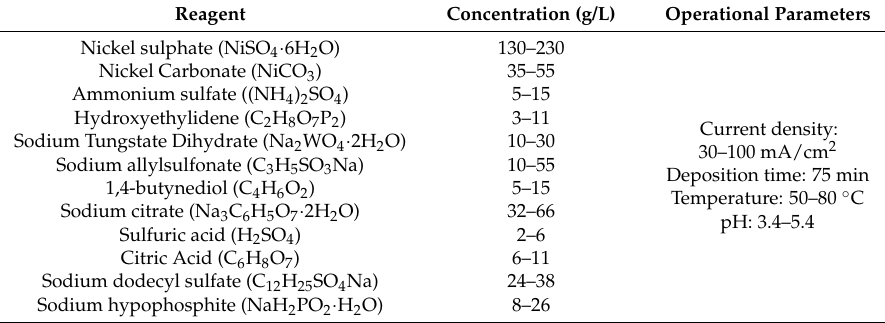
Table 1. Composition of the plating solution of the Ni-based deposition